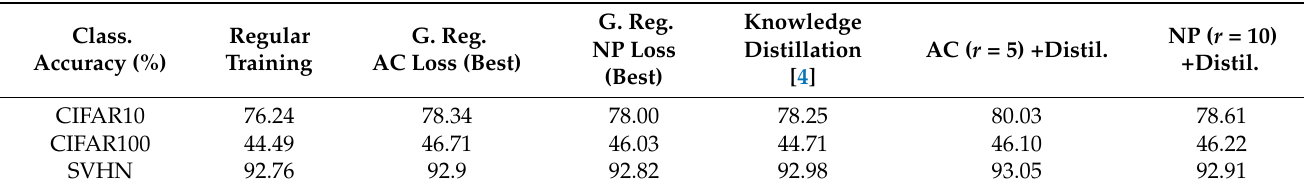
Table 4. Comparison of geometric regularization (G. Reg.) of local activations to Knowledge Distillation (Distil.) and their combination.